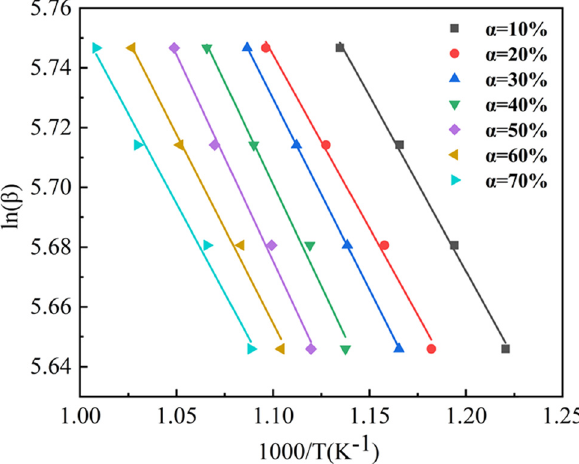
Figure 9: FWO method plots of sample K2 in di ff erent conversion degrees.